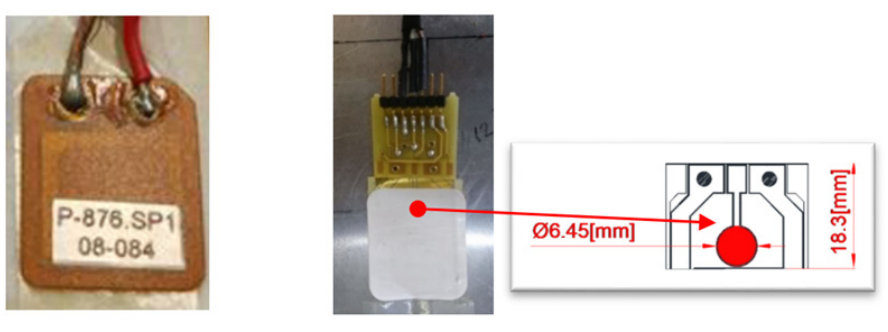
Figure 2. ( Left ) Piezoceramic sensor PI_876.SP1. Piezopolymer (PVDF) sensor protected by a white adhesive label and electrical connections on a PCB. ( Right ) Circular element of 6.45 mm diameter shown by the red circle on the CAD drawing.